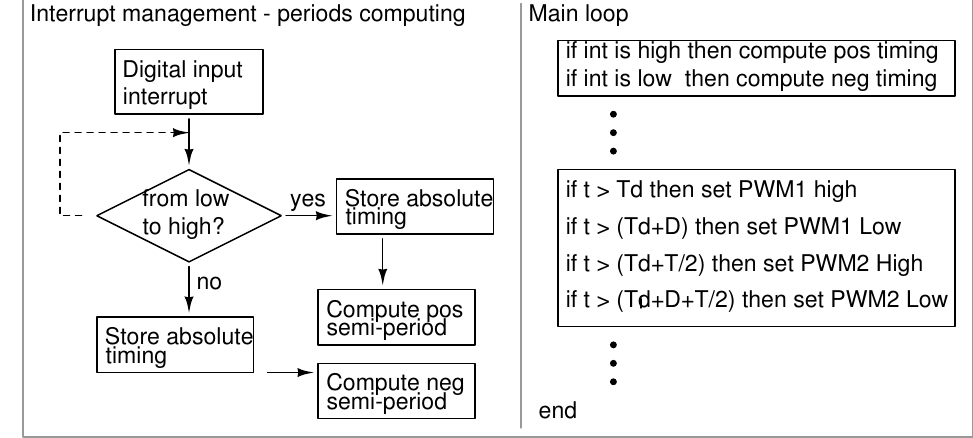
Figure 5. Simplified scheme of the real-time code for Arduino. The interrupt is driven by the Schmitt trigger output signal (Figure